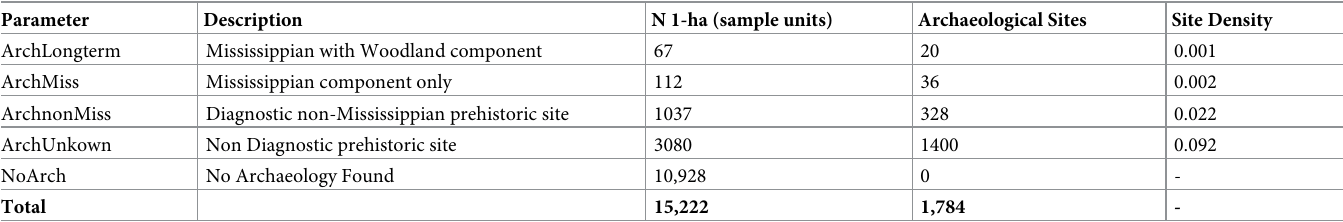
Table 3. Summary of sample units in comparison to archaeological sites in